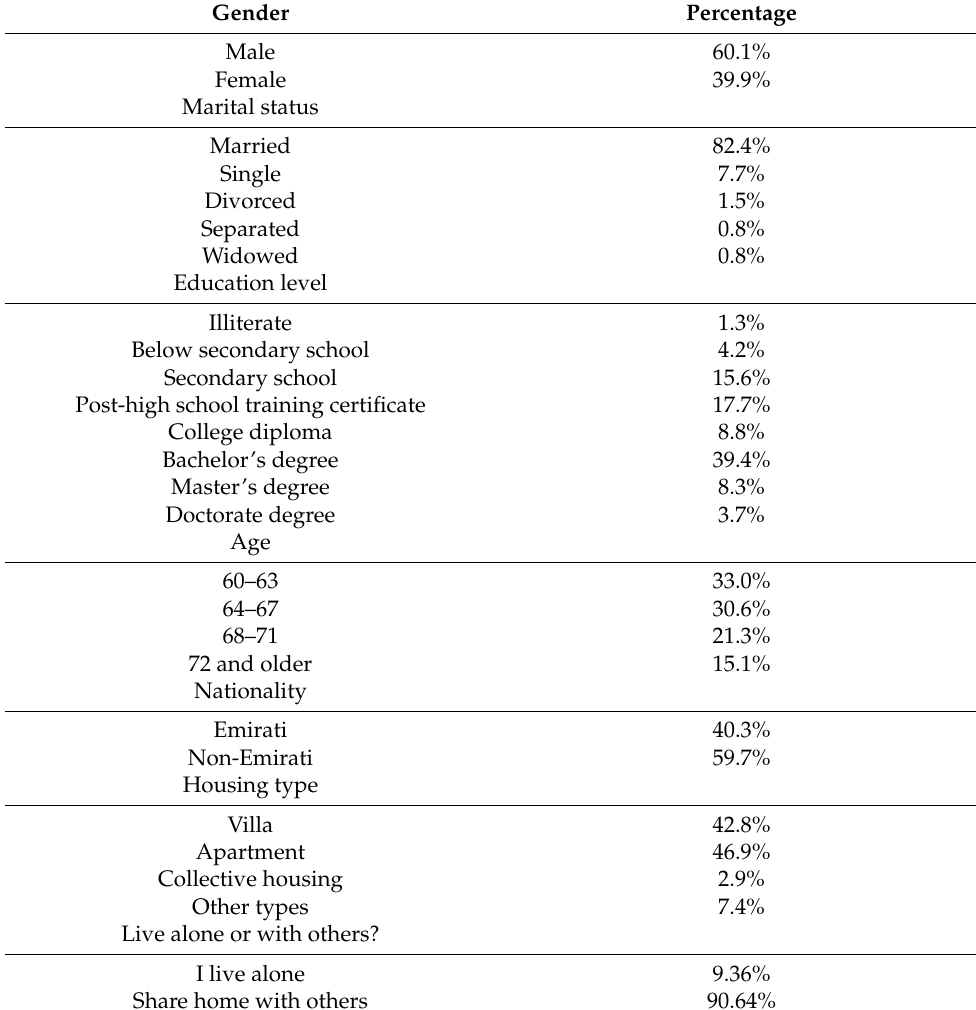
Table 1. Respondent’s